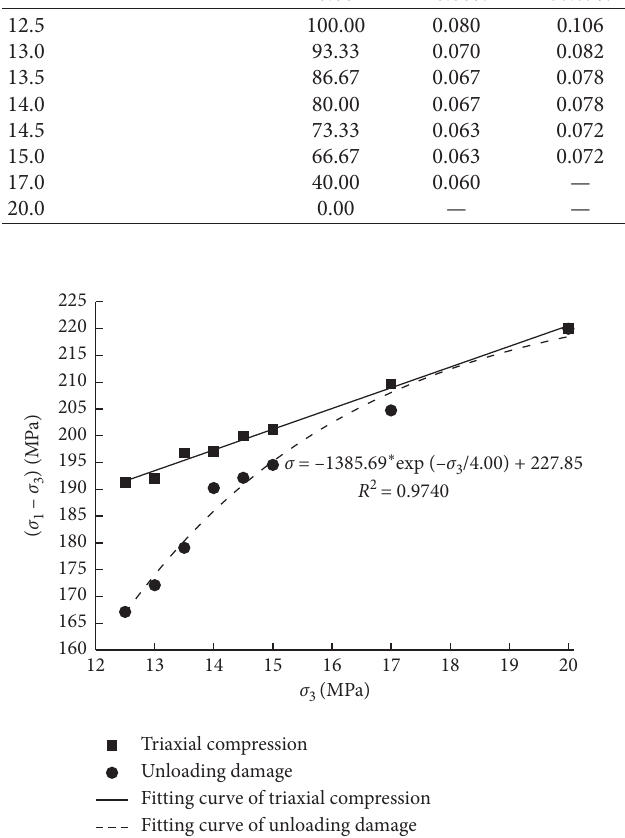
Figure 7: The curves of peak strength and confining